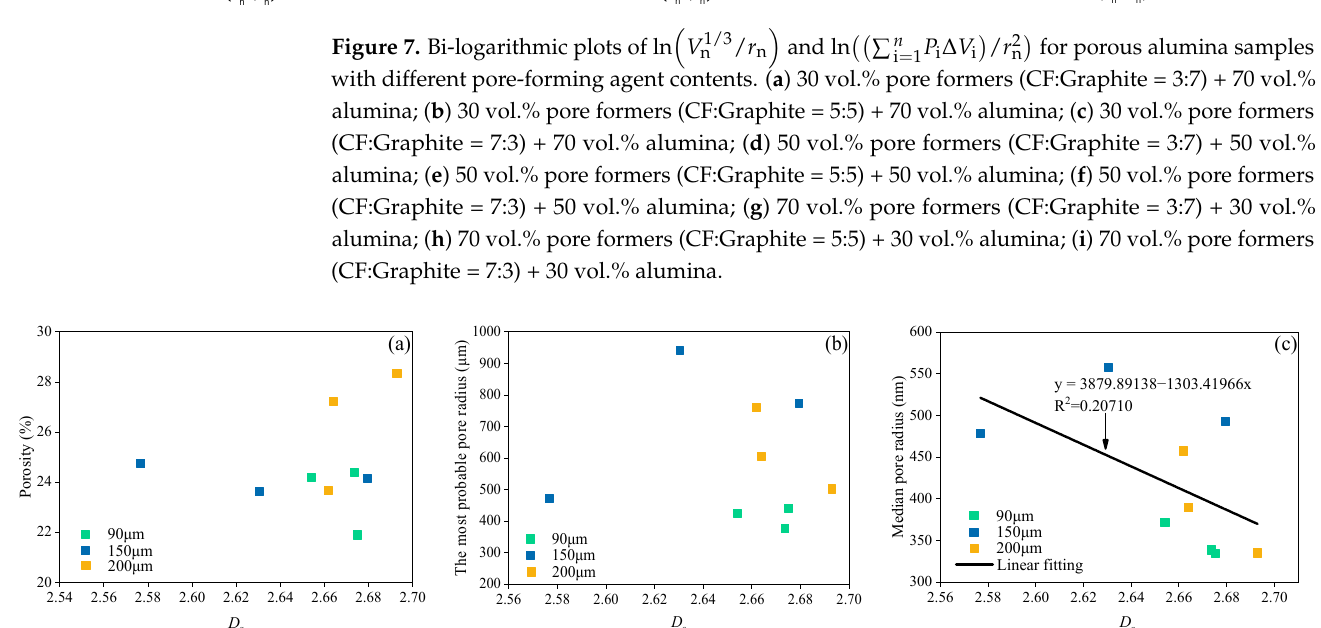
Figure 8. Relationship between D s and ( a ) porosity, ( b ) the most probable pore size, and ( c ) median pore radius for porous alumina samples with 30 vol.% pore-forming agents.